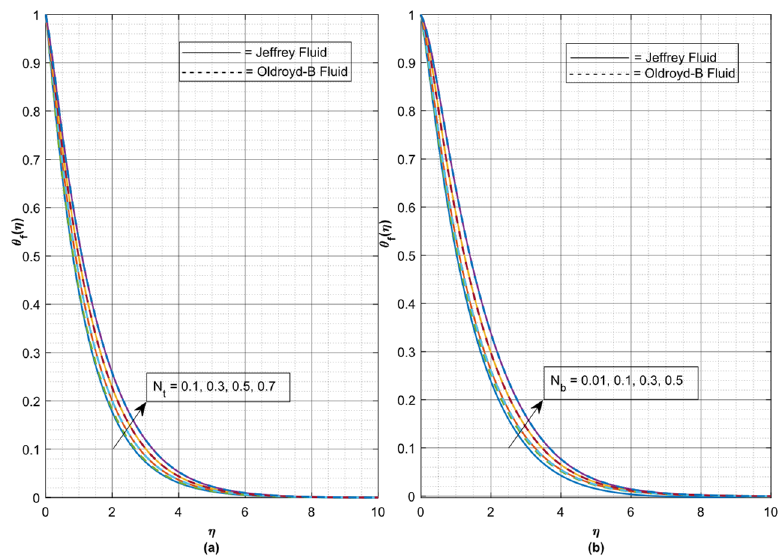
( ) ( ) θ η θ η N on N on and (b) Impact of . t b f f ( ) χ η N on of both Oldroyd-B and Jefferey t